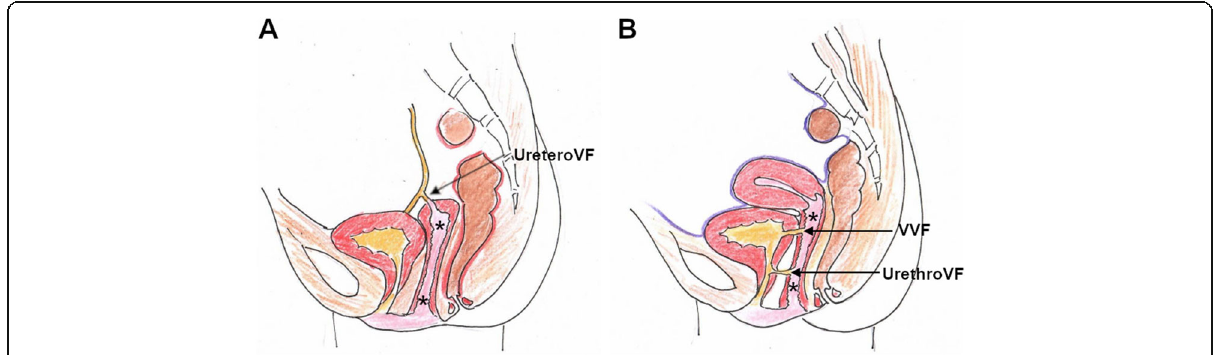
Fig. 2 Schematic representation of urinary VF. a uretero-VF (CVF). b vesico-VF (VVF) and urethro-VF. Note absent uterus in ( a ). Vagina indicated by asterisk (*), urine in yellow, stools in